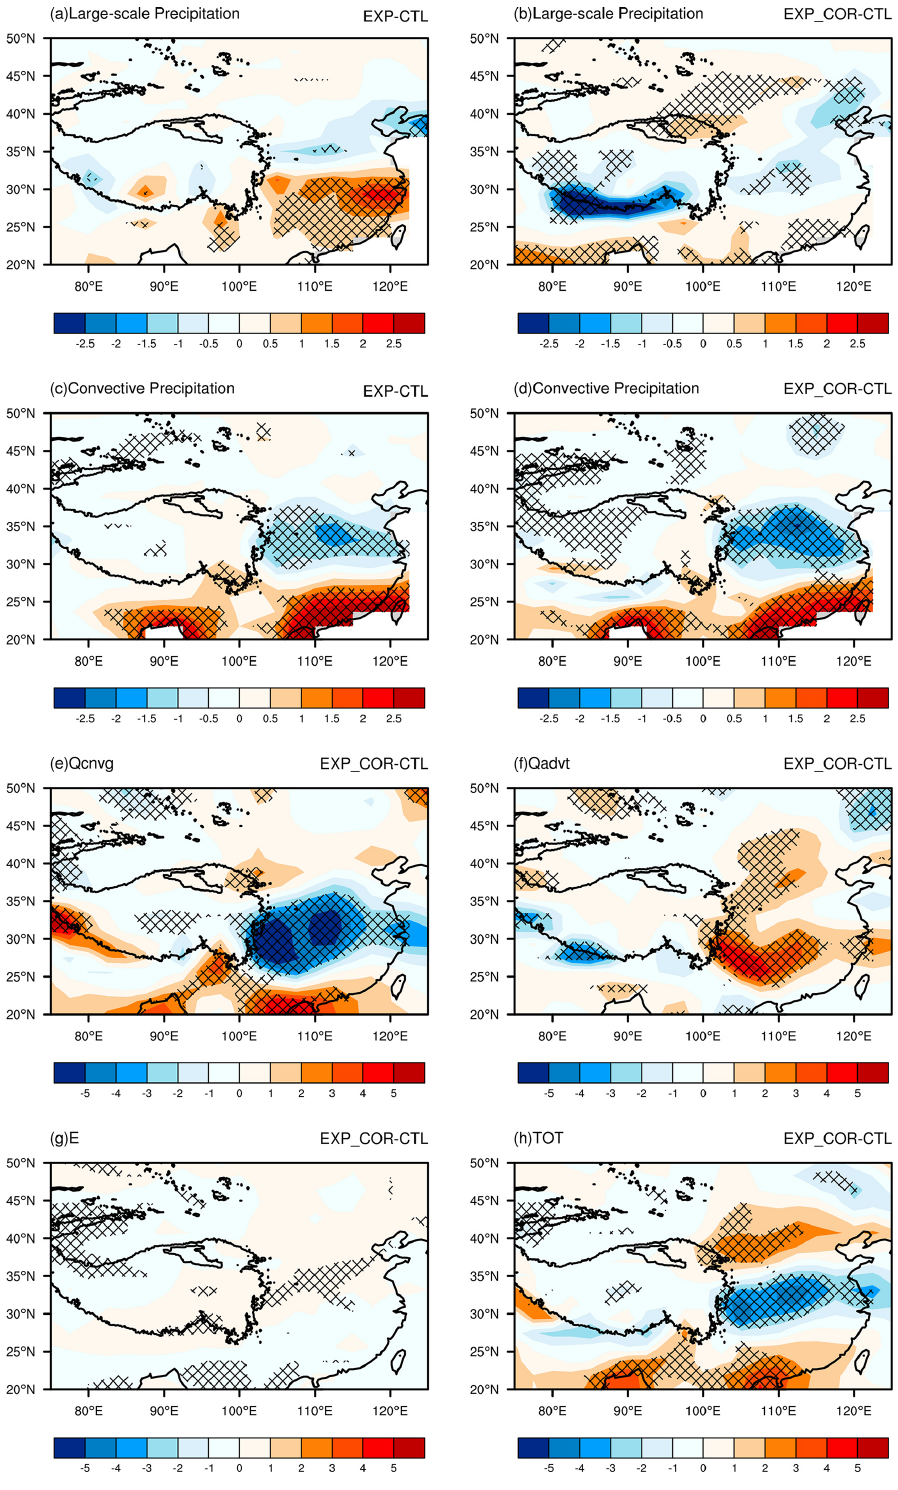
Figure 5. Spatial distribution of the differences in (a, b) large-scale precipitation and (c, d) convective precipitation between (left) EXP and CTL and between (right) EXP_COR and CTL and the differences in (e–h) the contributions (moisture convergence Q cnvg , moisture advection Q advt , evaporation E and the sum TOT) to total precipitation between EXP_COR and CTL. The crossed areas are significant at the 95%